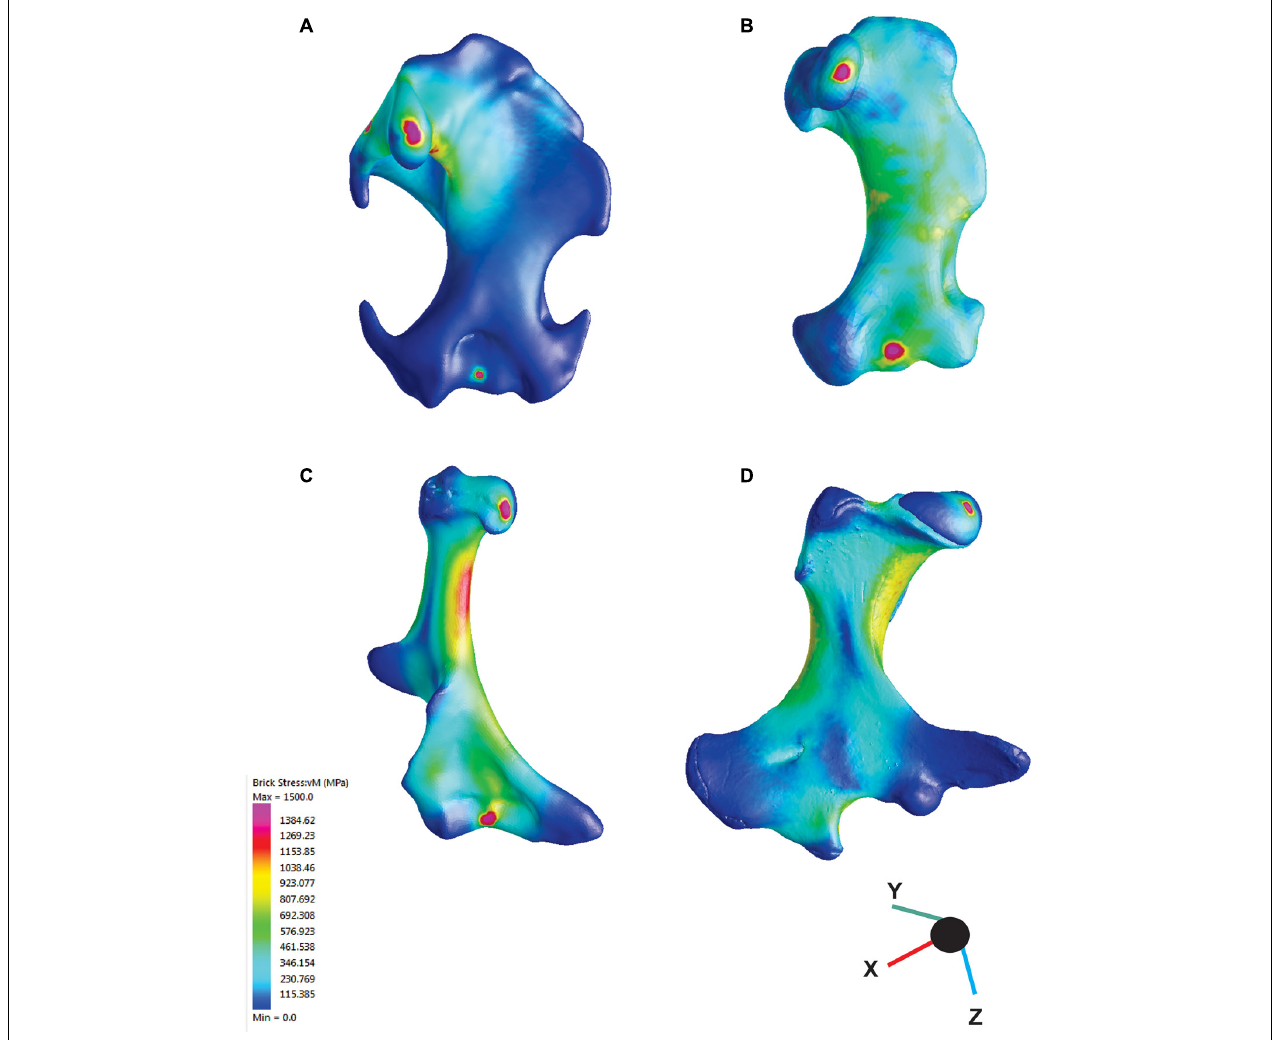
FIGURE 3 | Results from finite element analysis (FEA). Colors represent the intensity of the mechanical stress, warmer colors indicate high stress areas, cooler colous indicate low stress areas. (A) Mogera wogura , (B) Neurotrichus gibbsii , (C) Naraboryctes philcreaseri , (D) Tachyglossus aculeatus